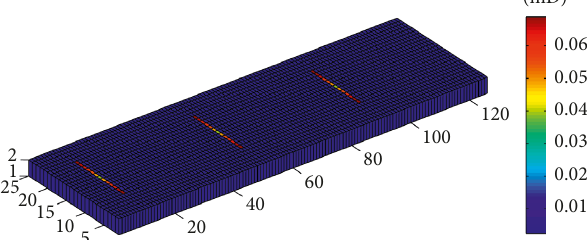
Figure 12: Shale gas reservoir simulation model (permeability